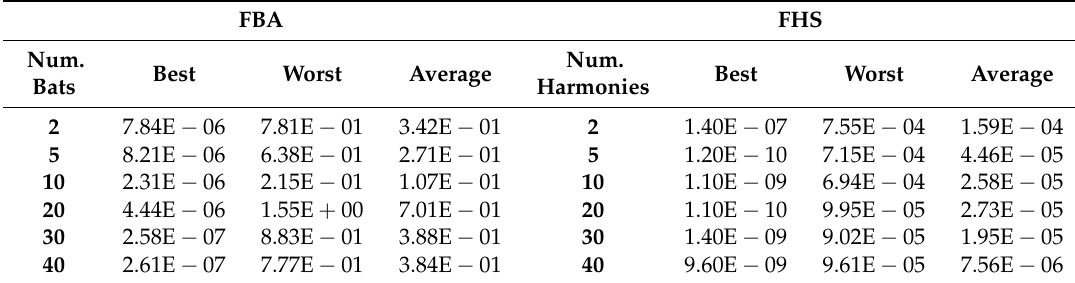
Table 16. Experiment results for the Zakharov function with the FBA and FHS algorithms. FBA FHS Num. Num.